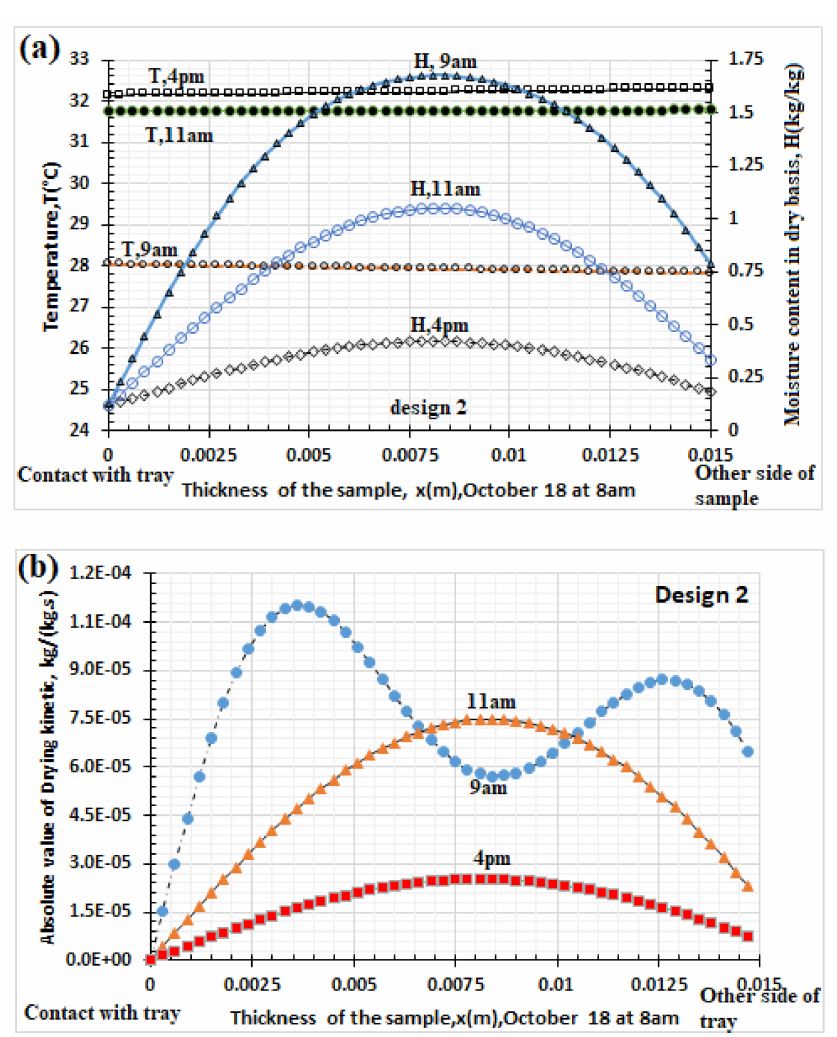
Figure 9. The distribution of the temperature and moisture content in the thickness of the product for 18 October; initial local drying time was 8:00 am at Yaound é . Temperature and moisture content ( a ) and drying kinetic ( b ) using design